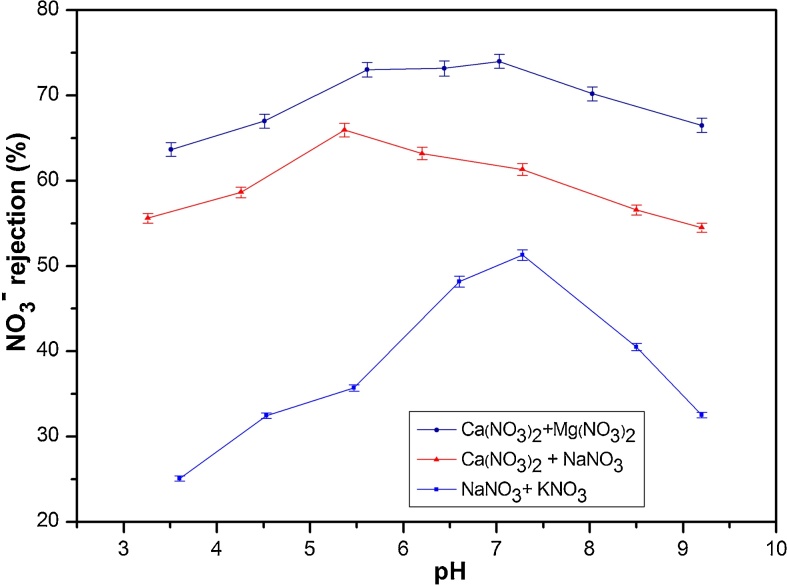
Influence of feed pH on NO3− rejection (%) in ternary solutions (NaNO3 + KNO3) (NaNO3 + Ca(NO3)2), (Mg(NO3)2 + Ca(NO3)2) (at fixed ΔP and Ci of 6 bar and 50 mg (NO3−)/L).